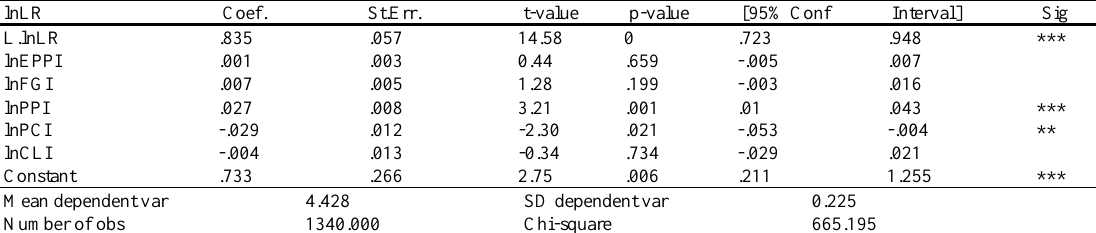
Table 6 : Generalized method of moments (GMM)